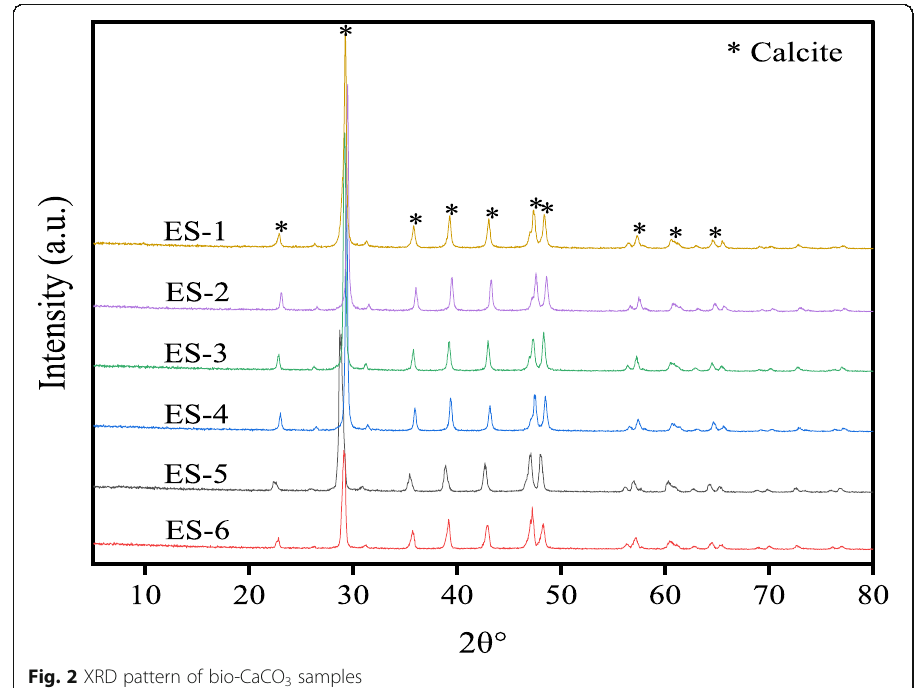
Fig. 2 XRD pattern of bio-CaCO 3